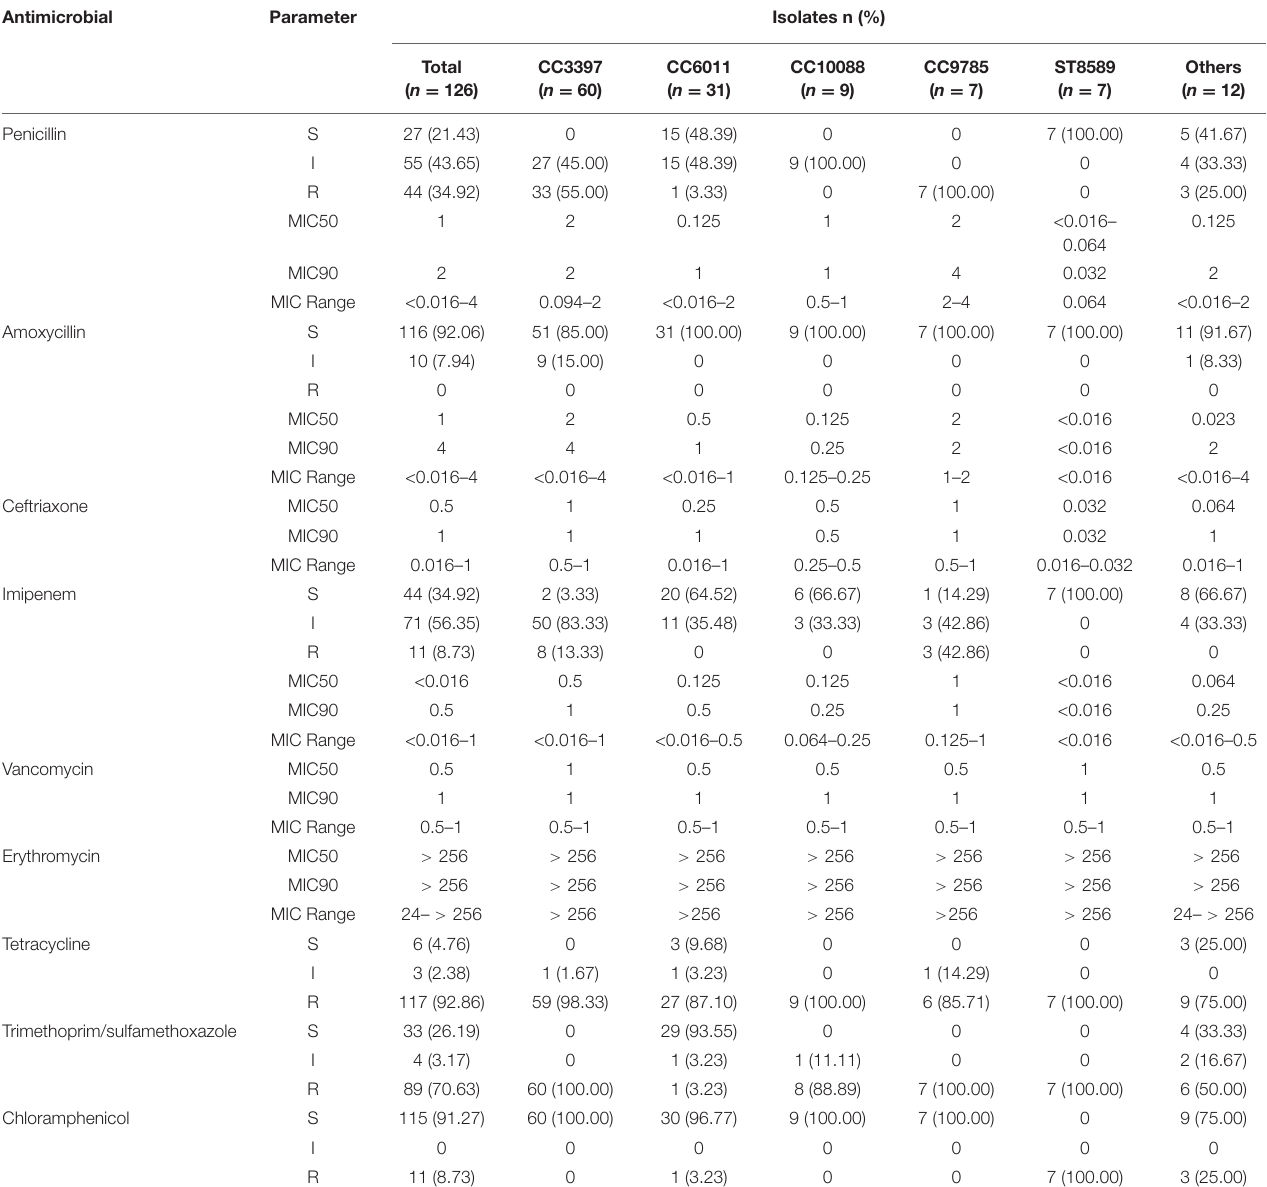
TABLE 4 | Antimicrobial susceptibility of the 126 strains by clonal complex.